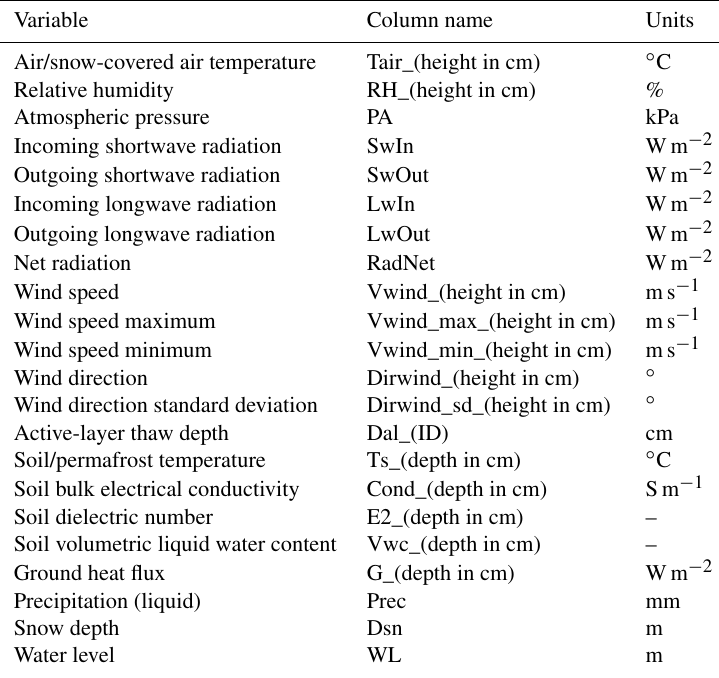
Table G1. Overview of all variables published as a time series. Some variables have _center, _rim and _slope as their location index (Sect. 3.2). Additional level 2 data are published for the variables air temperature, relative humidity, precipitation, wind speed and direction, net radiation, soil temperatures, and soil volumetric liquid water content, which is indicated by _lv2 in the column name. If an air temperature sensor is covered by snow and thus measures snow temperature, this is indicated by a Flag 8 in the